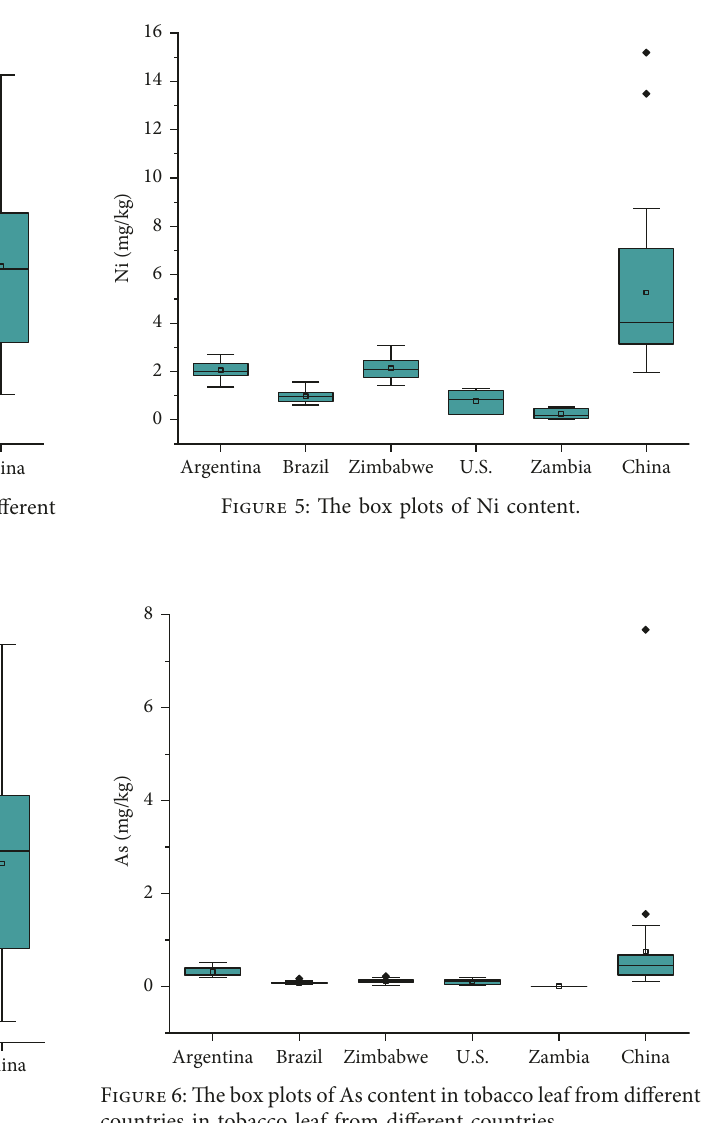
Figure 3: The box plots of Co content.